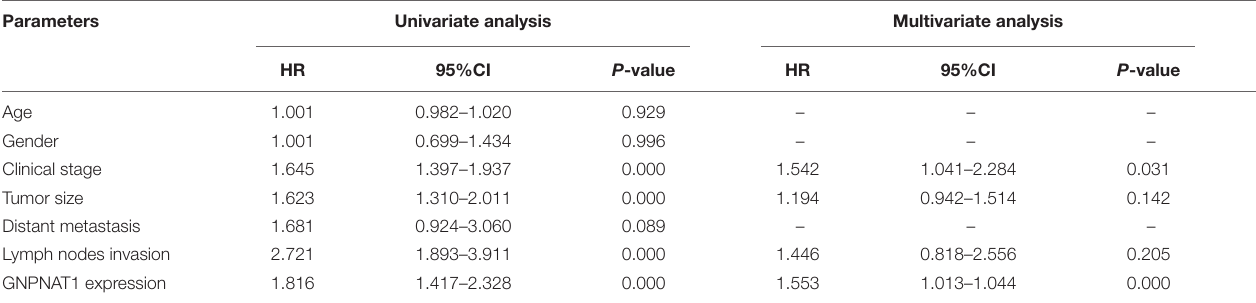
Figure 6E . GNPNAT1 Expression Associated With Immune Cell Infiltration Tumor IMmune Estimation Resource results noted that GNPNAT1 expression was negatively correlated with B